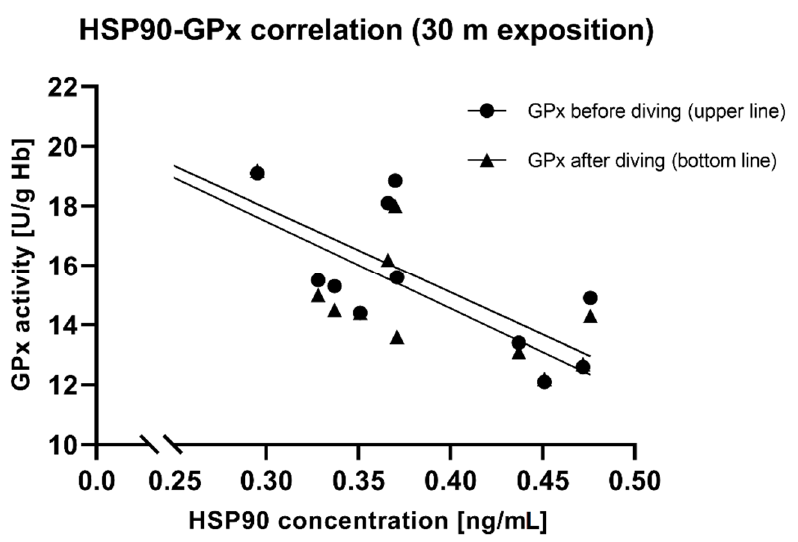
Figure 6. Correlation between HSP90 concentration and GPx activity in RBC (before diving, r = − 0.79, p < 0.05; after diving r = − 0.81, p < 0.05), 30 m exposition.